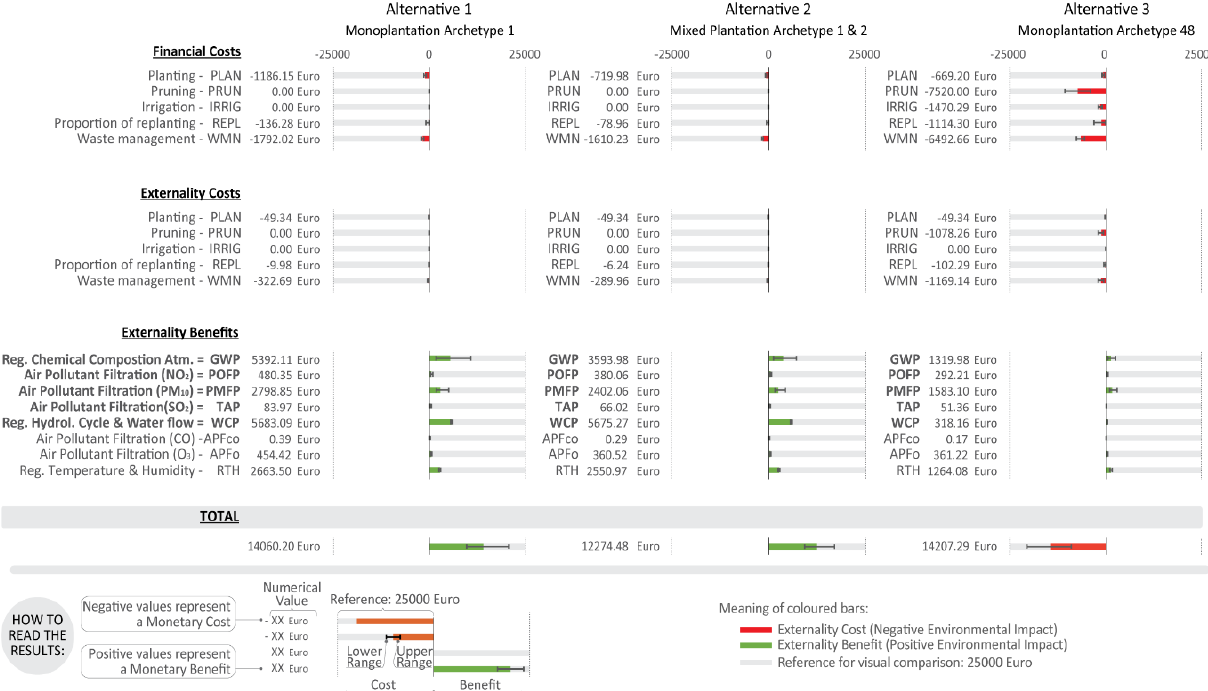
Figure 16. Comparison of the benefits (positive externalities) and costs (financial and negative externalities) in monetary units per life cycle phase and as a net total value. Costs are represented in red and benefits in green.